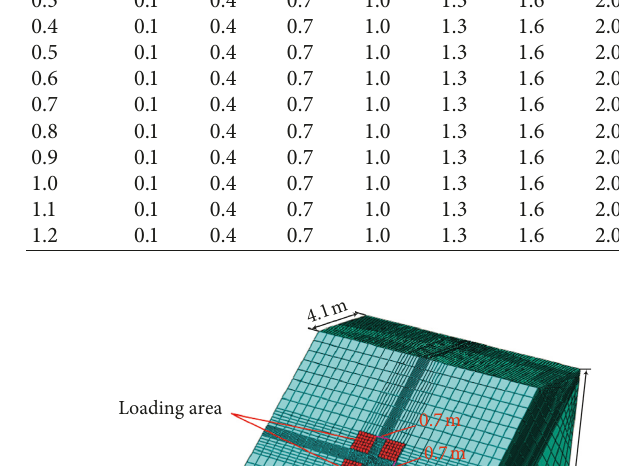
z and b under different a